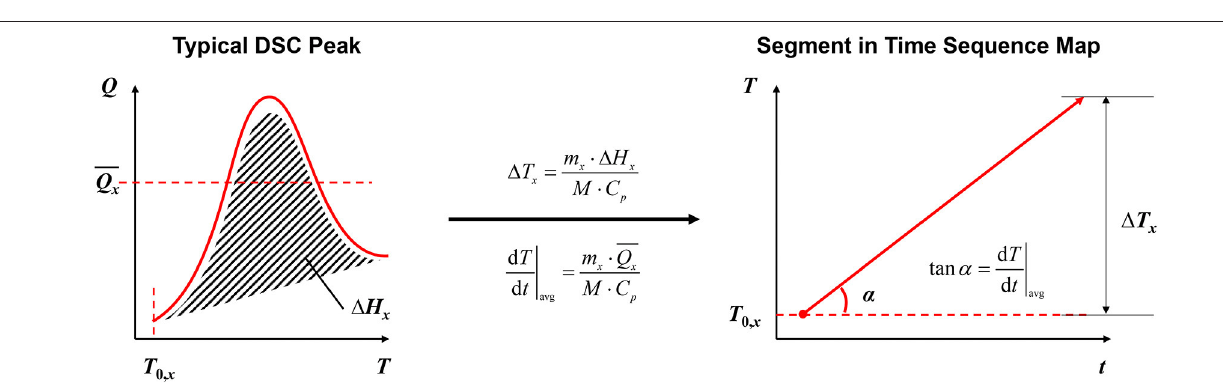
FIGURE 5 | Transformation from typical DSC peak to segment in the Time Sequence